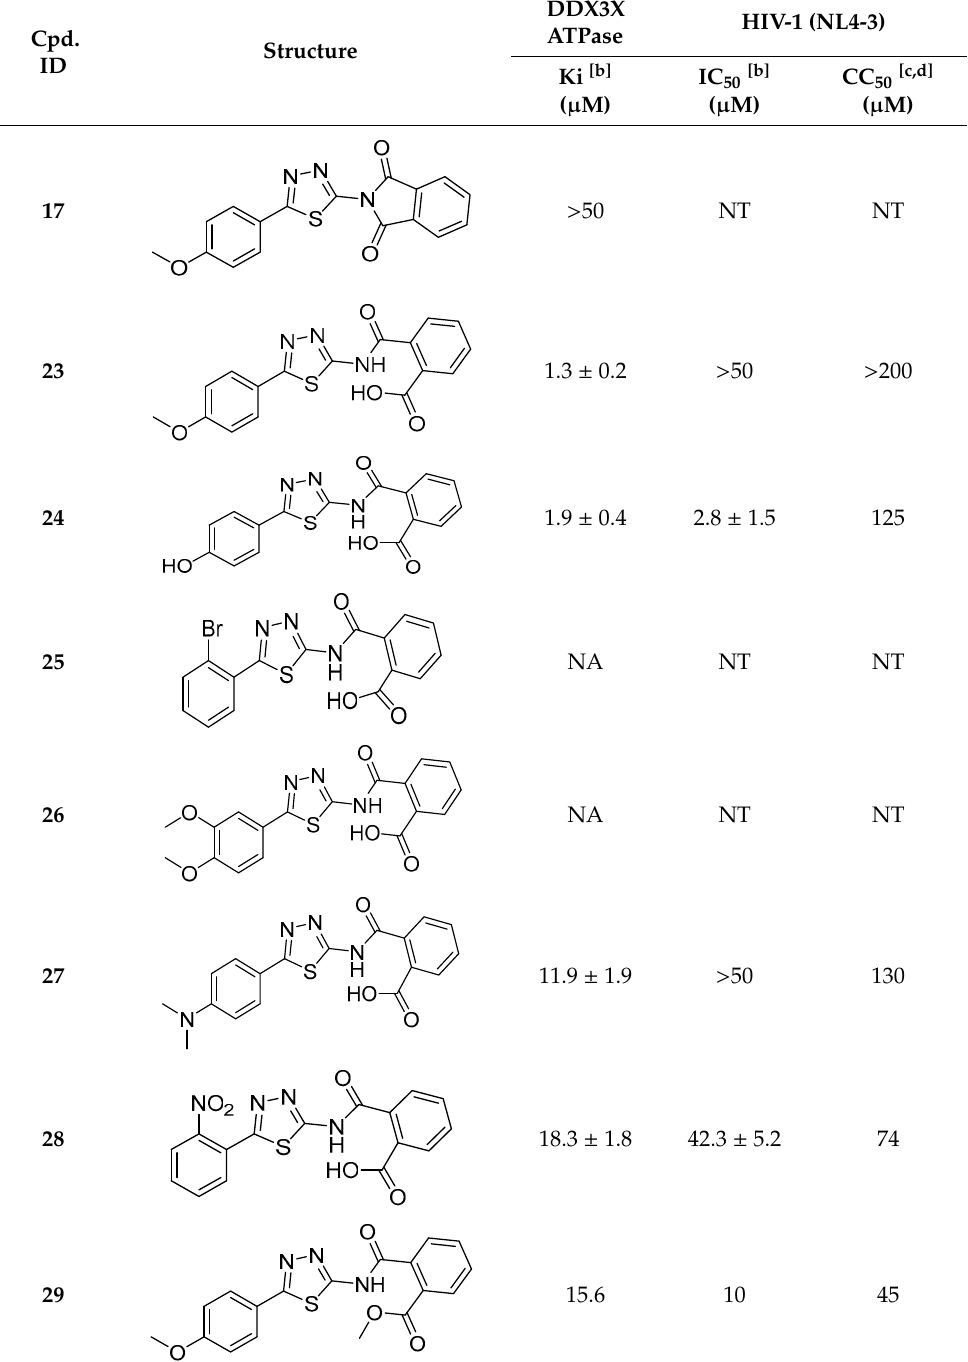
Table 1. Biological evaluation of selected compounds against DDX3X ATPase and HIV-1 infected cells [a] . Cpd.